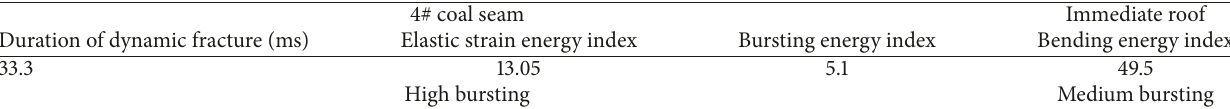
Table 3: Testing results of intrinsic bursting